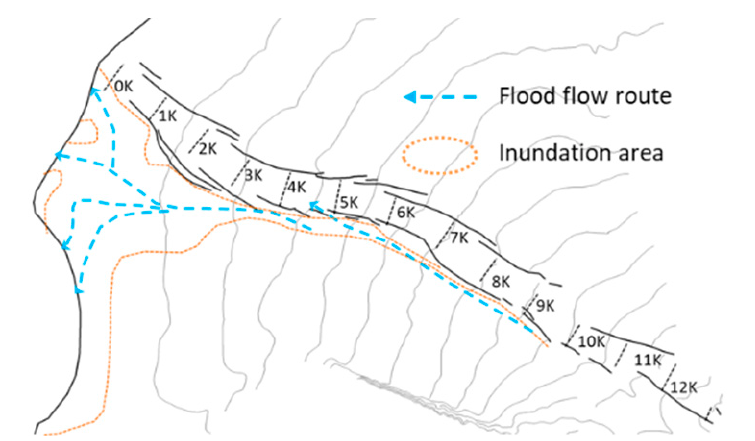
Figure 15. Inundation flow in 1934 estimated by Teramura